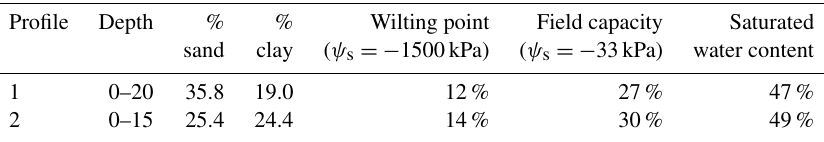
Table C1. Wilting point, field capacity, and saturated water content of soil in volumetric soil water content calculated from soil texture by Roth (2006) at the Chamau site using the methods by Saxton et al. (1986). Wilting point and field capacity were calculated from Eqs. (C1)– (C3) given the soil water potential ψ s = − 1500kPa and ψ s = − 33kPa, respectively. Saturated water content was calculated from Eq.